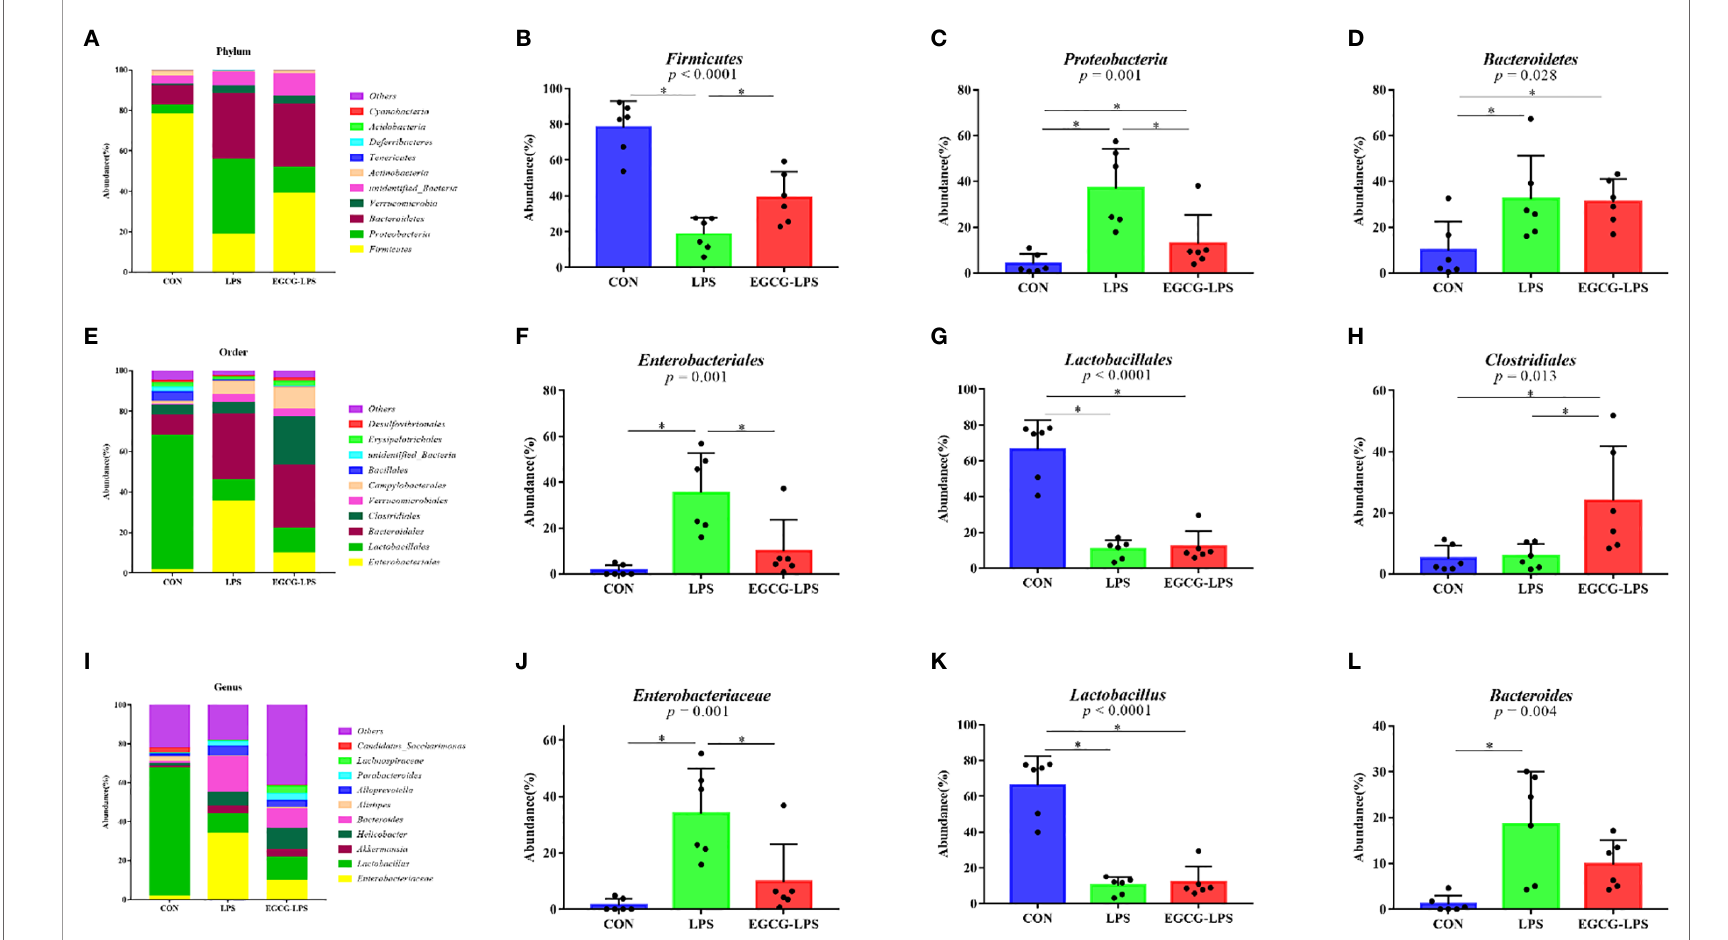
FIGURE 5 | The protective effect of the intragastric administration of EGCG on the intestinal micro fl ora of mice. (A) Relative abundance of gut microbiota phyla; (B) percentage of Firmicutes in each sample from the three groups; (C) percentage of Proteobacteria in each sample from the three groups; (D) percentage of Bacteroidetes in each sample from the three groups; (E) relative abundance of gut microbiota orders; (F) percentage of Enterobacteriales in each sample from the three groups; (G) percentage of Lactobacillales in each sample from the three groups; (H) percentage of Clostridiales in each sample from the three groups; (I) relative abundance of gut microbiota genus; (J) percentage of Enterobacteriaceae in each sample from the three groups; (K) percentage of Lactobacillus in each sample from the three groups; (L) percentage of Bacteroides in each sample from the three groups. * p <0.05 ” * ” means that the horizontal line connects the p -value of the data between the two groups <0.05, and the “ P ” value in the fi gure represents the accurate value of p between the three groups of data, and some of the p values between the three groups are too small to be expressed as p